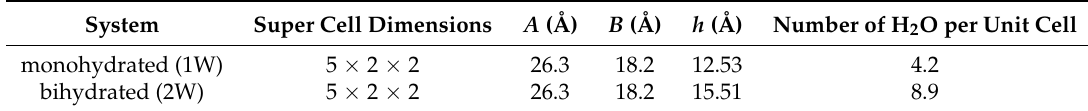
Table 4. Characteristics of the simulations boxes for hydrated